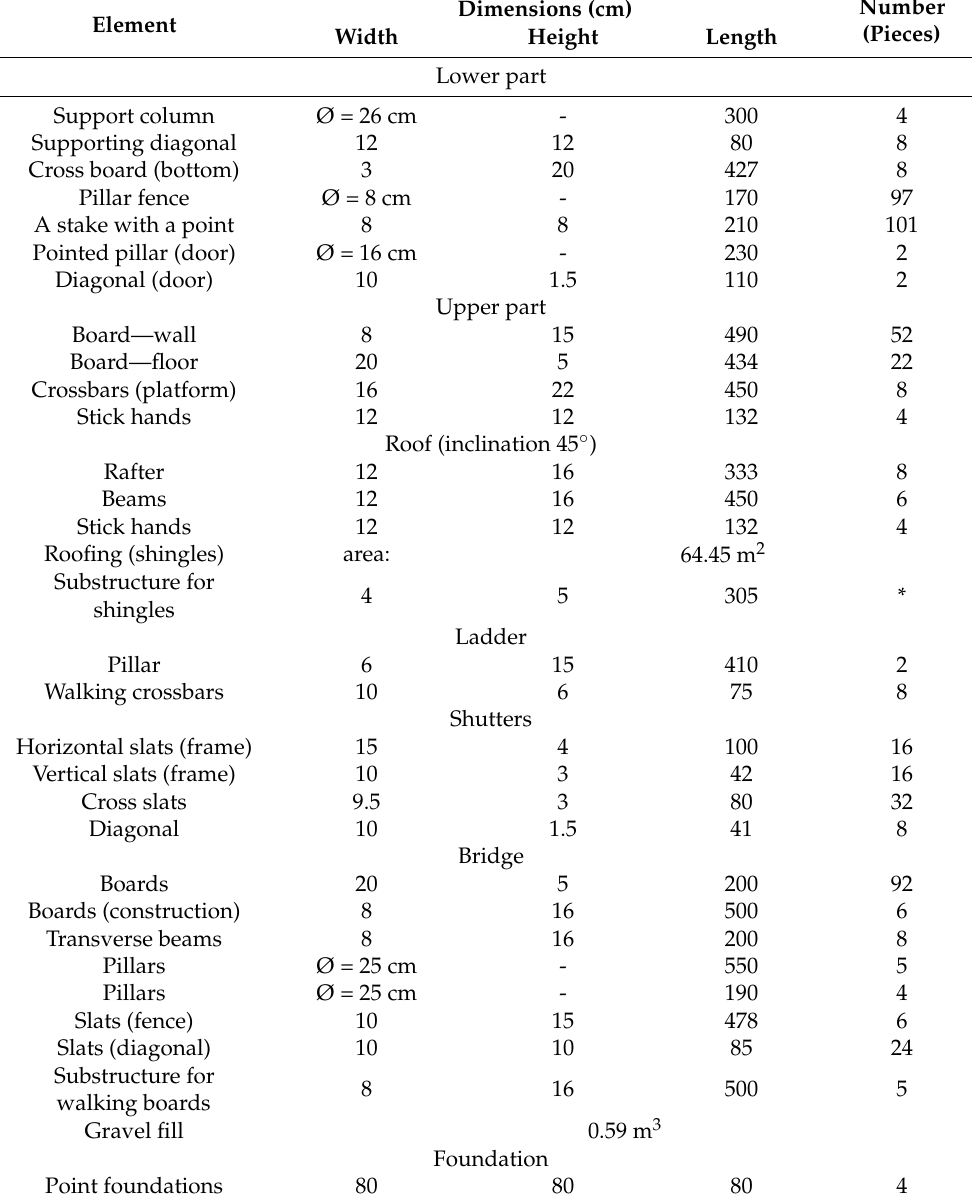
Table 2. Elements of the